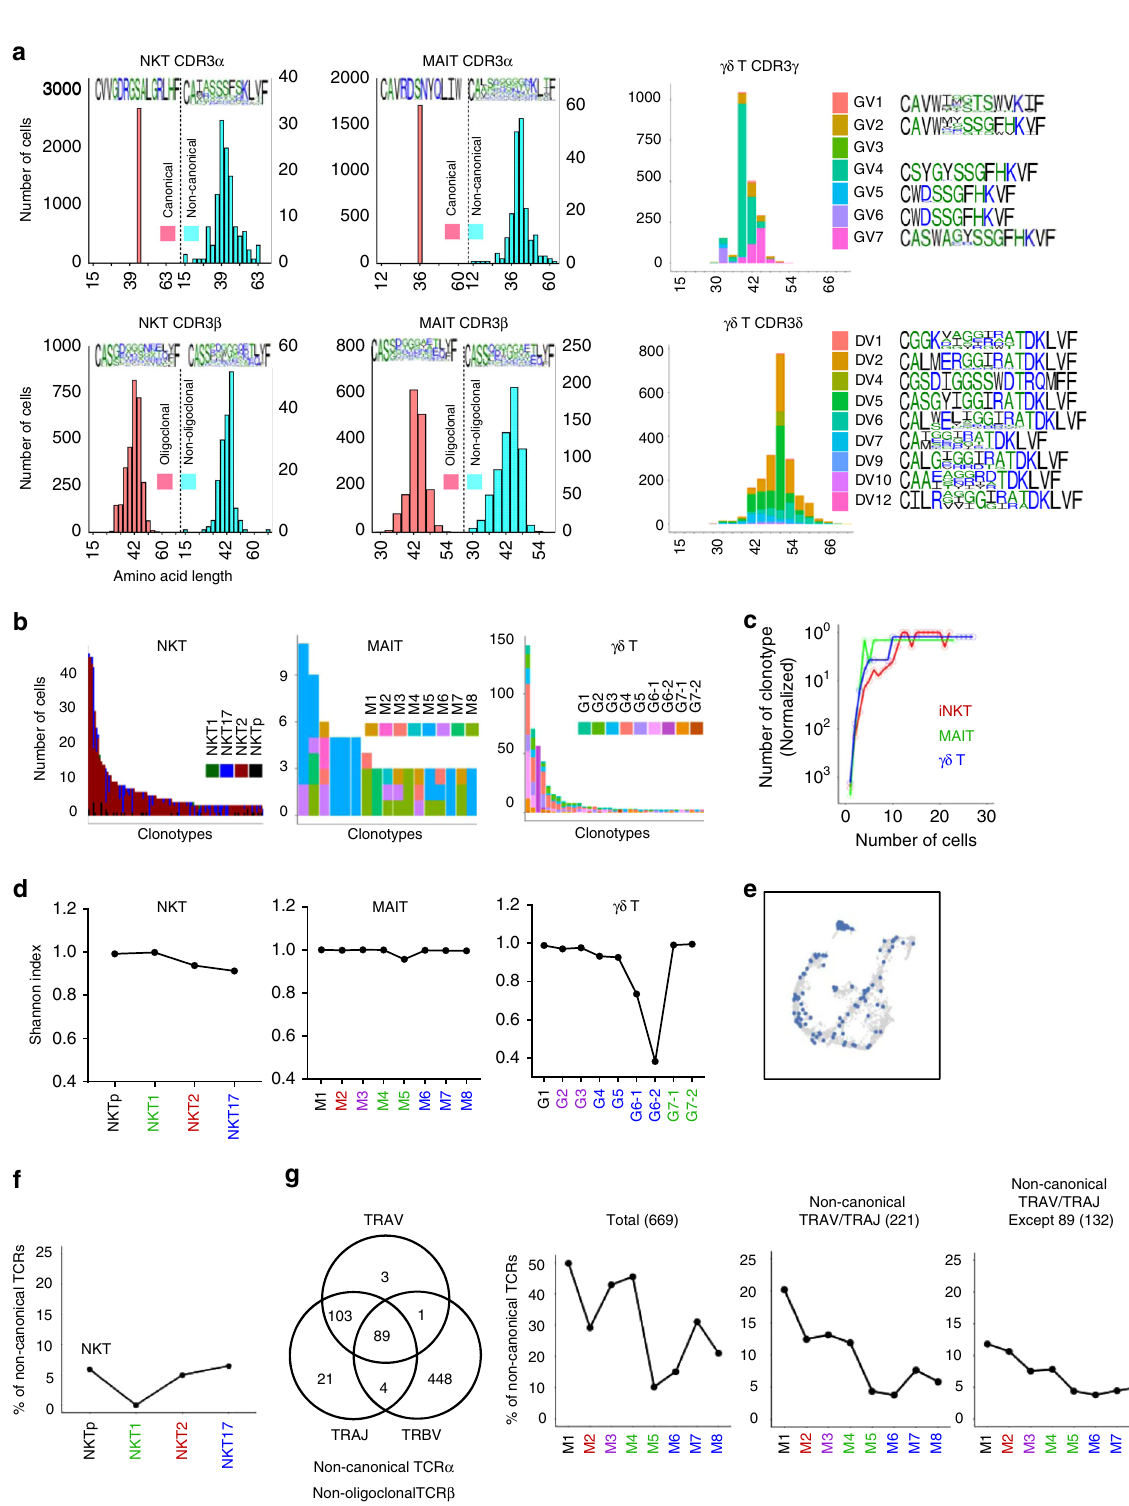
Next, we analyzed the non-canonical TCR α and/or non- oligoclonal TCR β usage of iNKT and MAIT cells. In iNKT cells, 204 out of 1898 clonotypes (10.7%) or 253 out of 2775 cells (9.1%) had at least one of the non-canonical TCR V α /J α and/or non- oligoclonal TCR V β chains (Fig. 4f, left and Supplementary Figs. 8E − G). The most frequent non-canonical TCR of iNKT cells was V α 10/J α 50, which was previously reported in J α 18 KO BALB/c mice 30 (Supplementary Fig. 8F). We detected three different